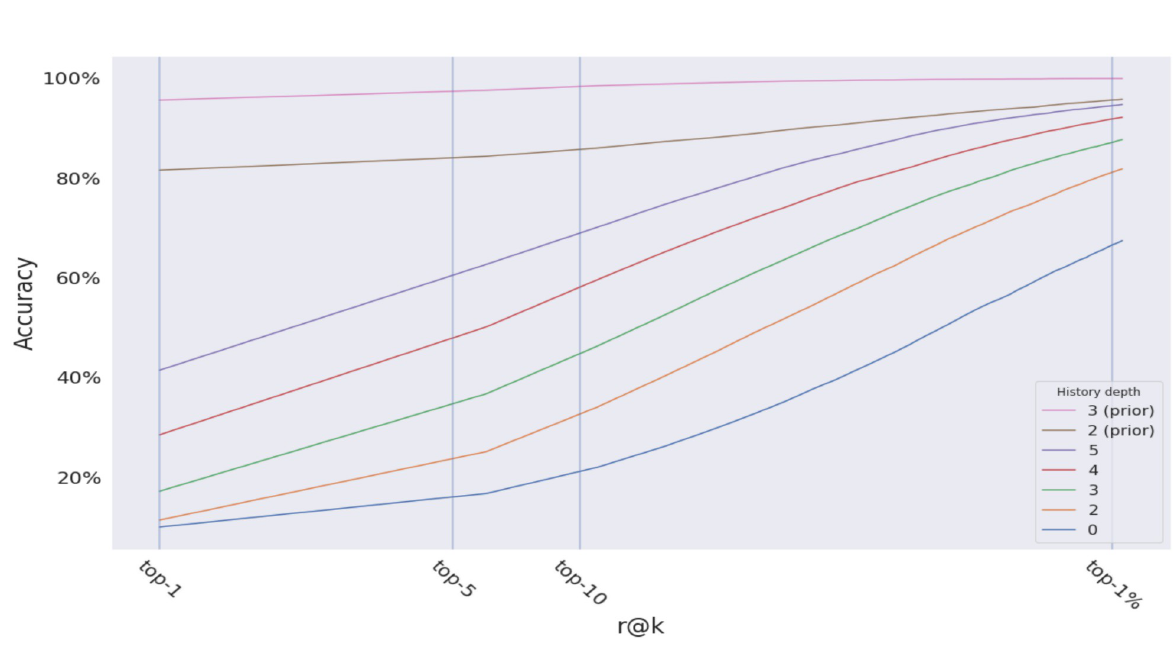
Fig 17. The effect of weak prior on naive history.